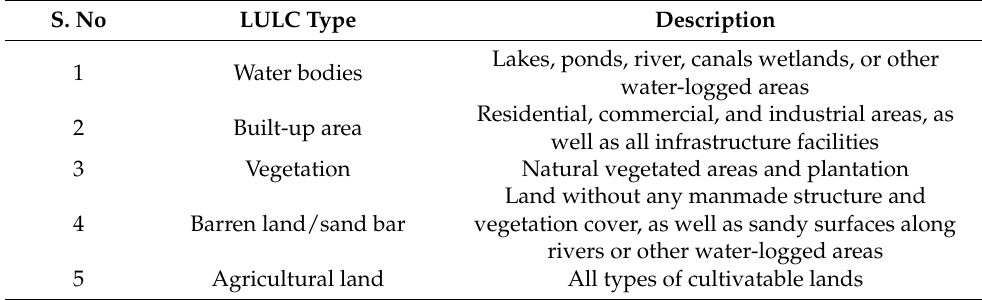
Table 2. Description of the LULC classes identified in the study